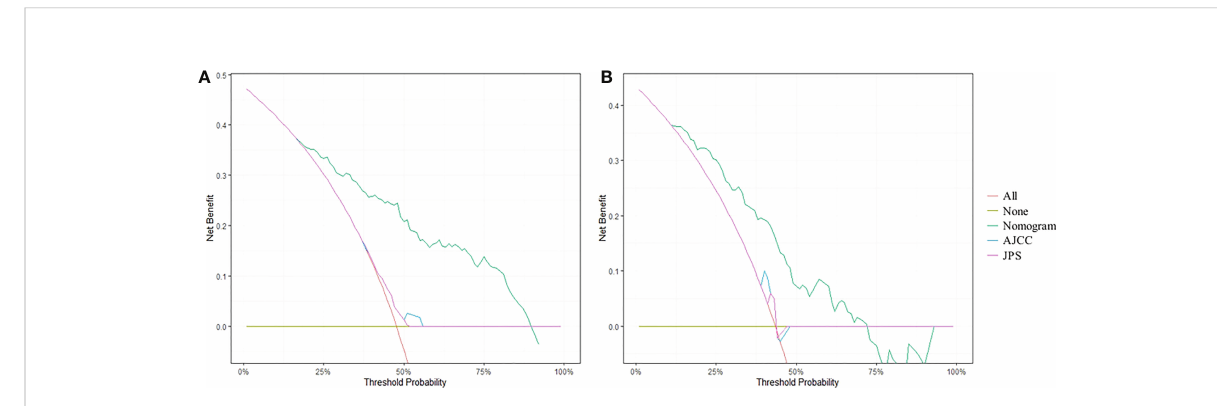
FIGURE 5 DCA curves for predicting 1-year liver metastasis-free survival based on nomogram as compared with 8th AJCC and 7th JPS stage system in the training cohort (A) and the validation cohort (B)